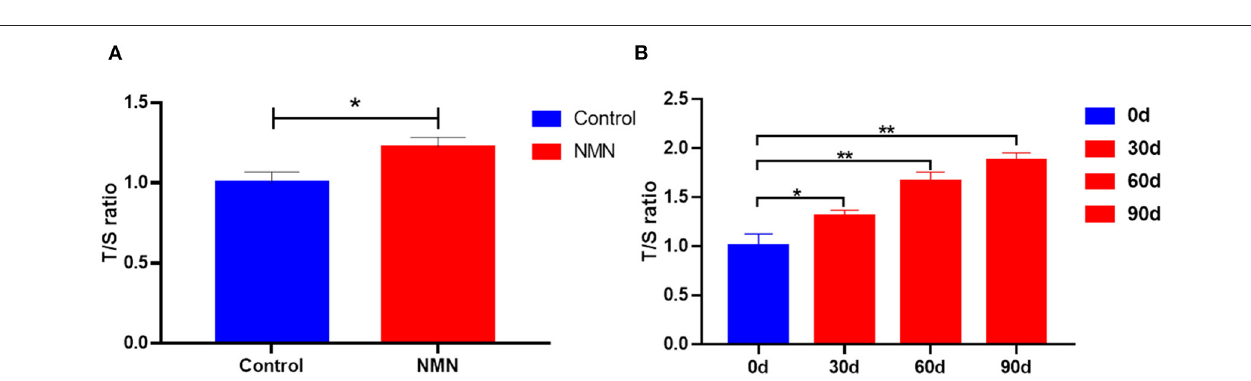
FIGURE 8 | Supplementary effect of NMN on the telomere length of the peripheral blood mononuclear cell (PBMC) in (A) pre-aging mice ( n = 6), and (B) pre-aging human volunteers ( n = 8). *Indicates significant difference at p < 0.05. **Indicates significant difference at p <